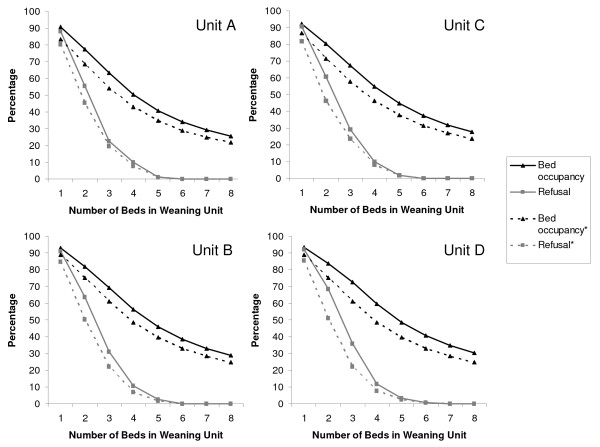
Modelling bed occupancy and admission refusal rates for four weaning units (A to D) with differing bed capacities. A refused admission occurs when a patient is eligible for transfer from ICU to the weaning unit, but the weaning unit is full. *The broken lines represent the effect of unstable patients being transferred out of the weaning unit back to the ICU.